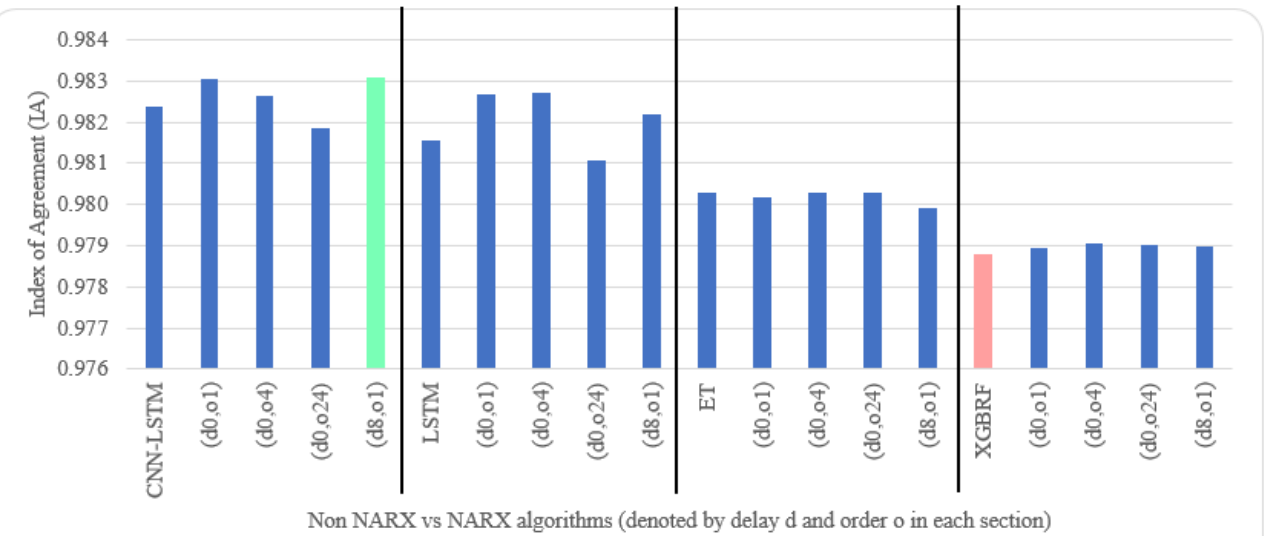
Figure 24. Evaluation results of non-NARX and NARX in terms of root mean square error for the Beijing dataset.